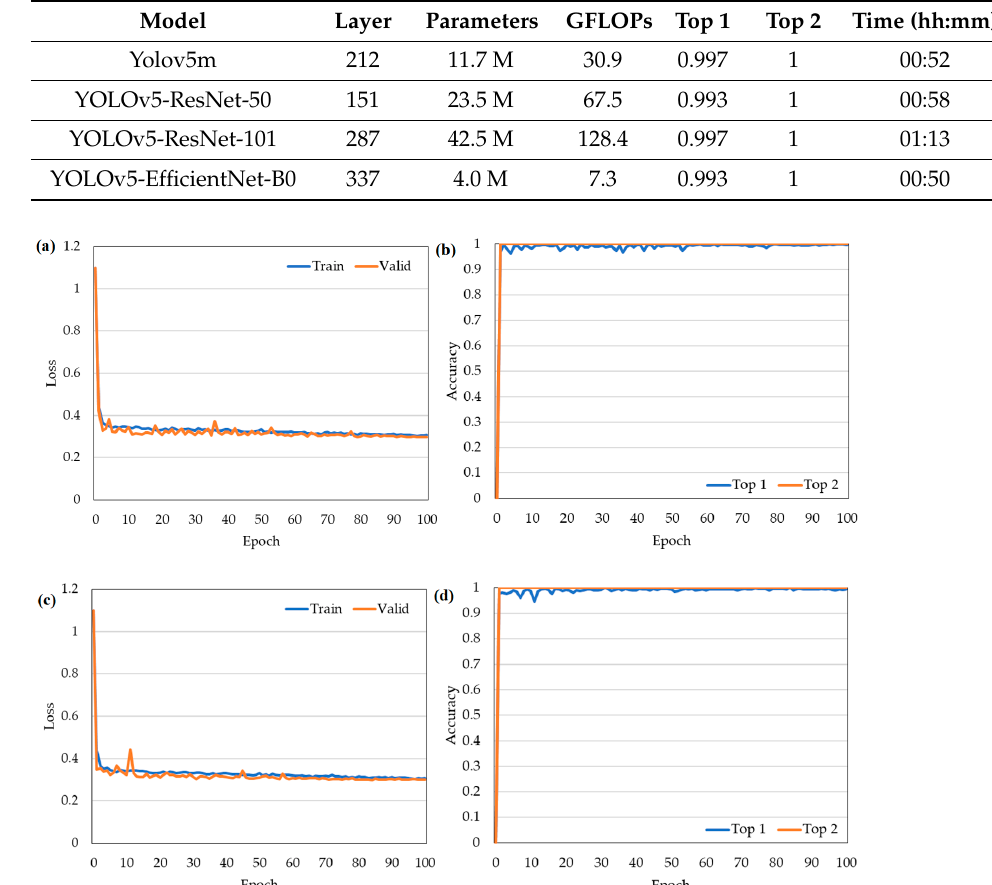
Table 1. Training model parameters and evaluation results of the four models.